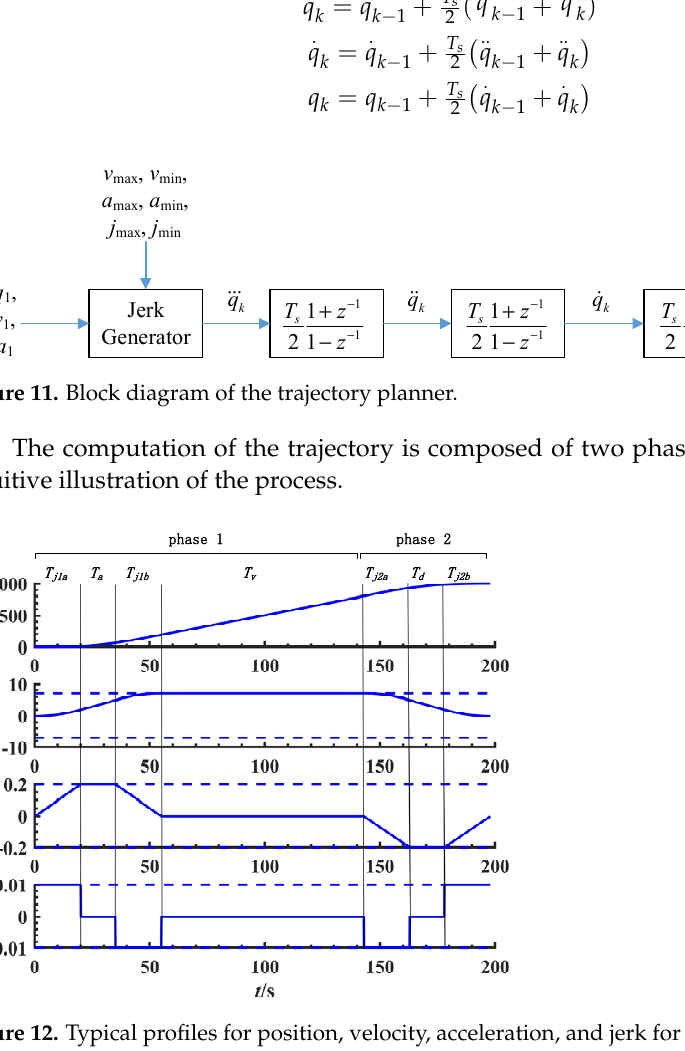
Figure 11. Block diagram of the trajectory planner.